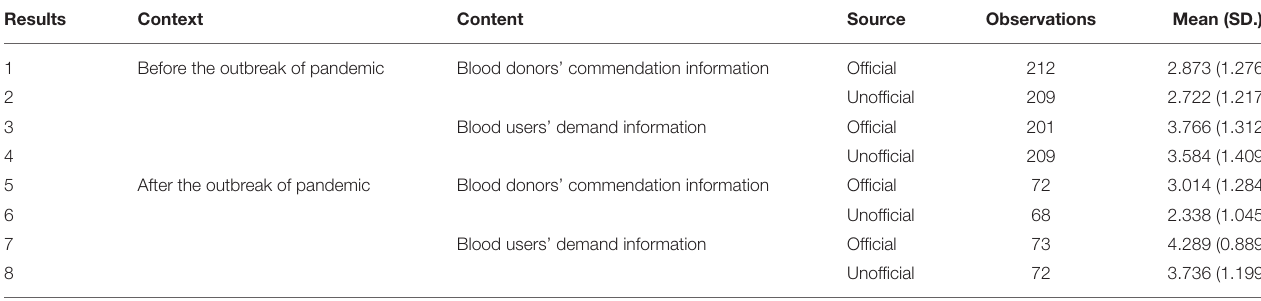
TABLE 3 | Results for the effects of social information on blood donation